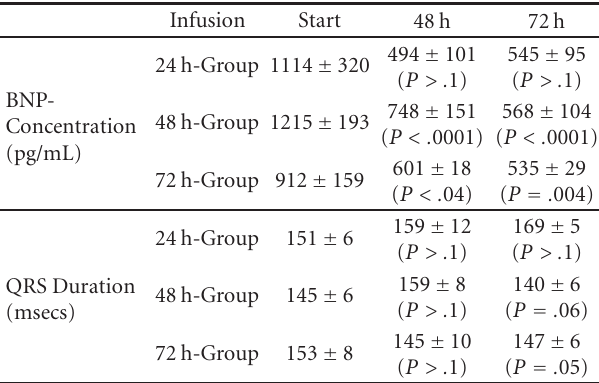
Table 3: Demographic statistics of the three subgroups (24h, 48h, and 72h infusion).